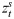
(a) Generative model for Hidden Markov Model (HMM). HMM is a state-space model consisting of latent discrete variables zts and observed rs-fMRI time series yts for each subject S. The discrete variables zts form a Markov chain with transition probabilities given by a multinomial distribution Ai,j. For a given state k, we model the rs-fMRI time series as a multi-normal distribution N(μk,Ck), with mean μk and covariance Ck. Given rs-fMRI datasets for S subjects, we estimate the posterior probabilities of the latent states and model parameters Φ = {π,A,Θ} (where, Θ={μk,Σk}k=1K) using variational Bayes methods. (b) Flowchart for VB-HMM. (i) Extract time series from M ROIs of S subjects; (ii) Use VB-HMM to estimate the posterior probabilities of states and model parameters Φ = {π,A,Θ}; (iii) Apply Viterbi decoding to estimate the most probable states; (iv) Compute the occupancy rate and mean lifetime of each state; and (v) Apply Louvain community detection on the estimated partial correlations to find network communities within each state. In the left panel, each of the 25 colors depicts a different state. The colors in the left panel match the colors used in the partial correlation matrices on the right.